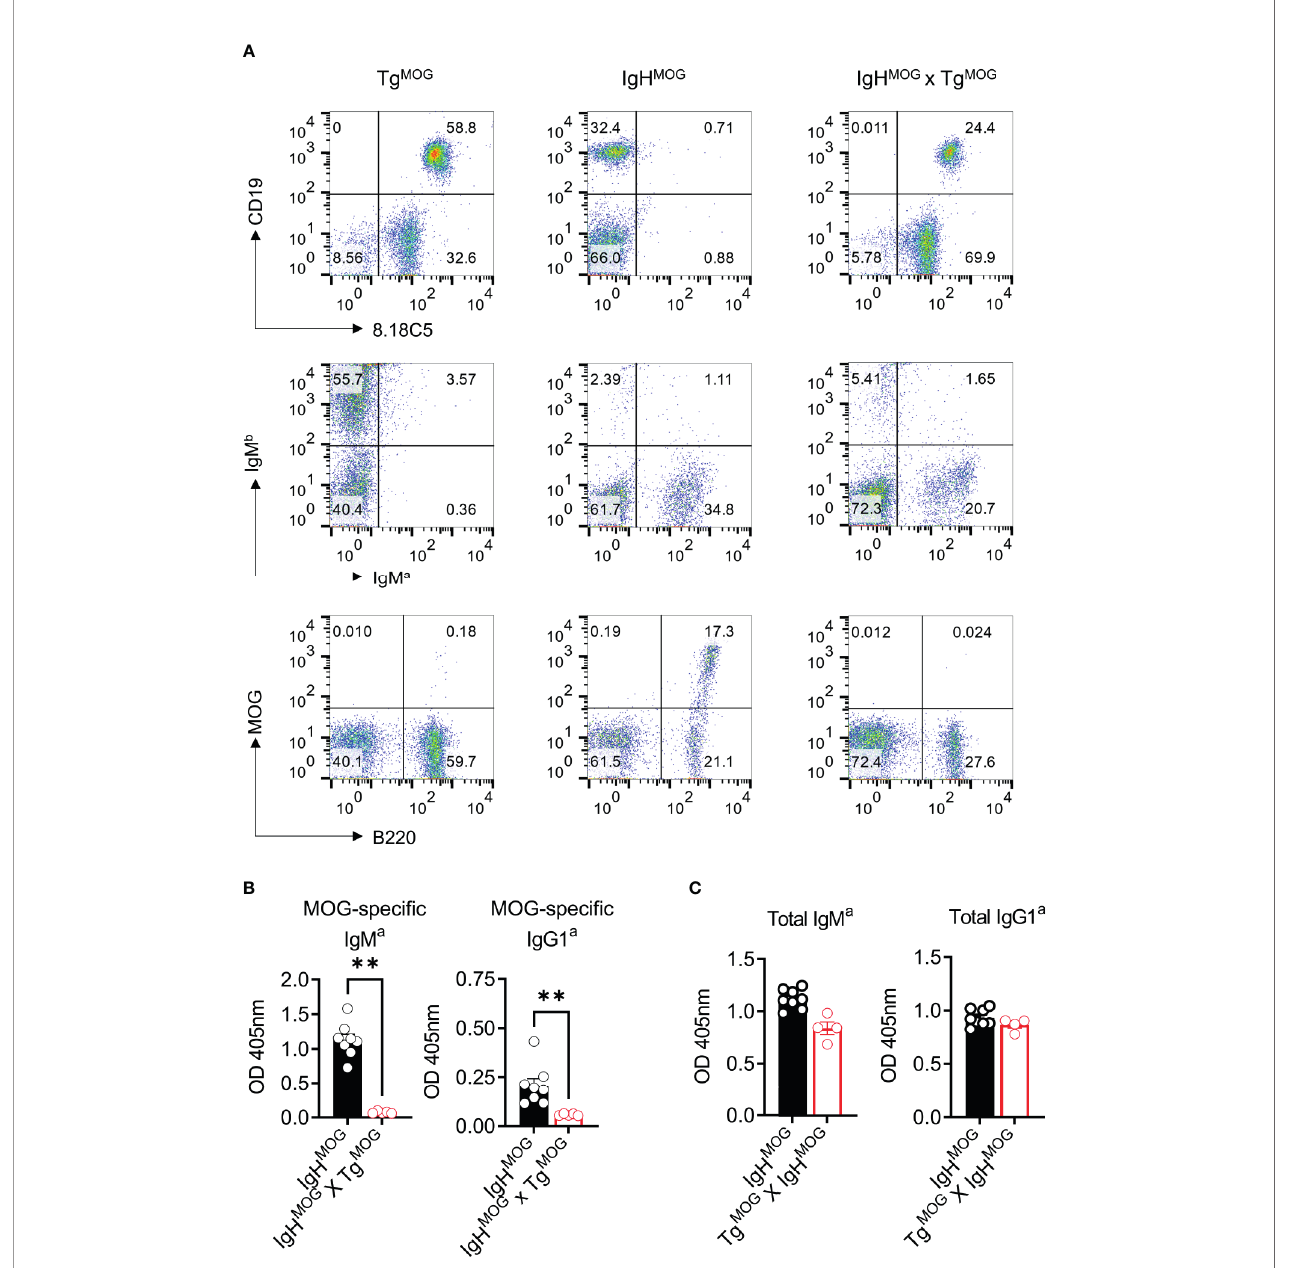
FIGURE 3 | MOG-speci fi c B cells are deleted in IgH MOG X Tg MOG mice. (A) , Representative fl ow cytometry data from Tg MOG , IgH MOG , IgH MOG X Tg MOG mice. Cells were stained with antibodies against transgenic anti-IgM a , WT anti-IgM b, anti-MOG 8.18C5 antibodies or recombinant MOG protein along with B cell lineage markers B220 and CD19. Representative data from two independent experiments is shown. (B, C) , MOG-speci fi c (B) , and total (C) IgM a and IgG1 a antibodies in the sera were quanti fi ed by ELISA. Each circle represents an individual mouse. n = 5 – 8 mice per group. **P = 0.0016 (Mann-Whitney ’ s U-test,